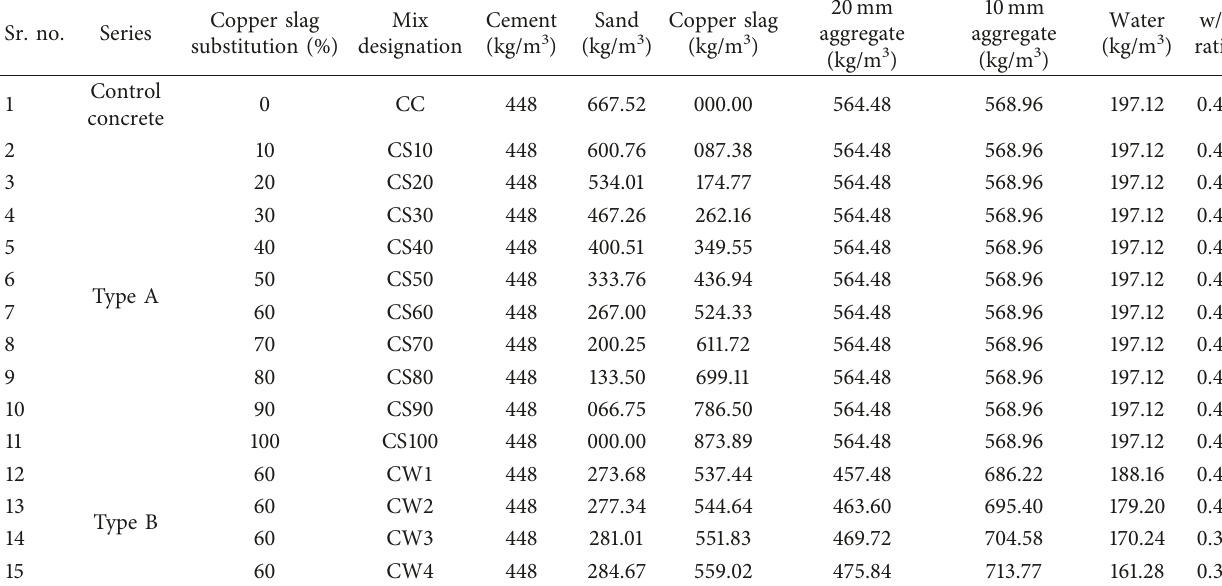
Table 2: Mix proportion of concrete mixes (quantities per m 3 of